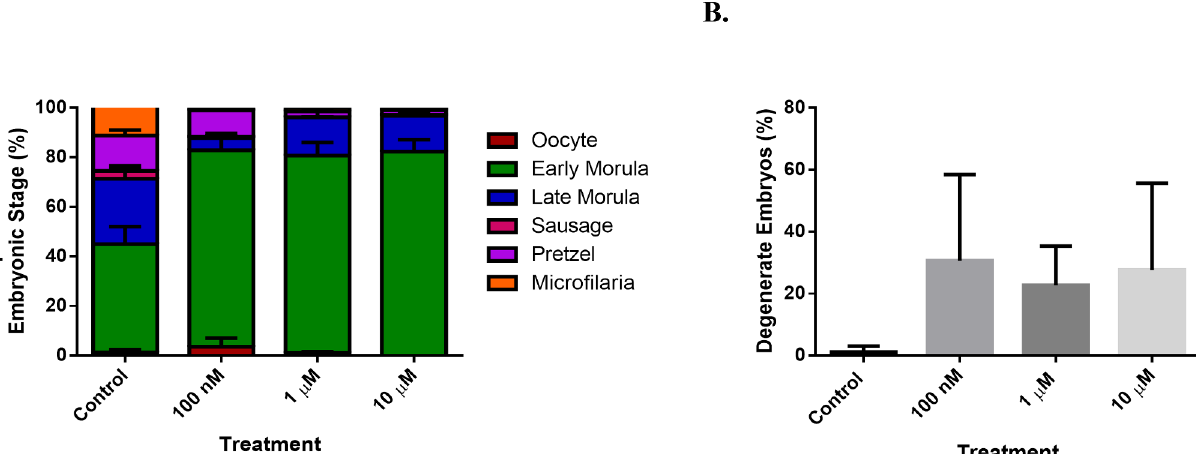
Fig 3. Effects of FLBZ on B . malayi embryogenesis. A. Embryograms for untreated and FLBZ-treated (24 hr exposure) females recovered four weeks post-transplantation. Two to four worms per treatment group were used for embryogram analysis. Data shown are % of oocytes, early and late morulae, pretzels and stretched mf in worm homogenates. Significantly more early developing embryos were observed in treated groups ( P < 0.001). B. Proportion of degenerating intrauterine stages.